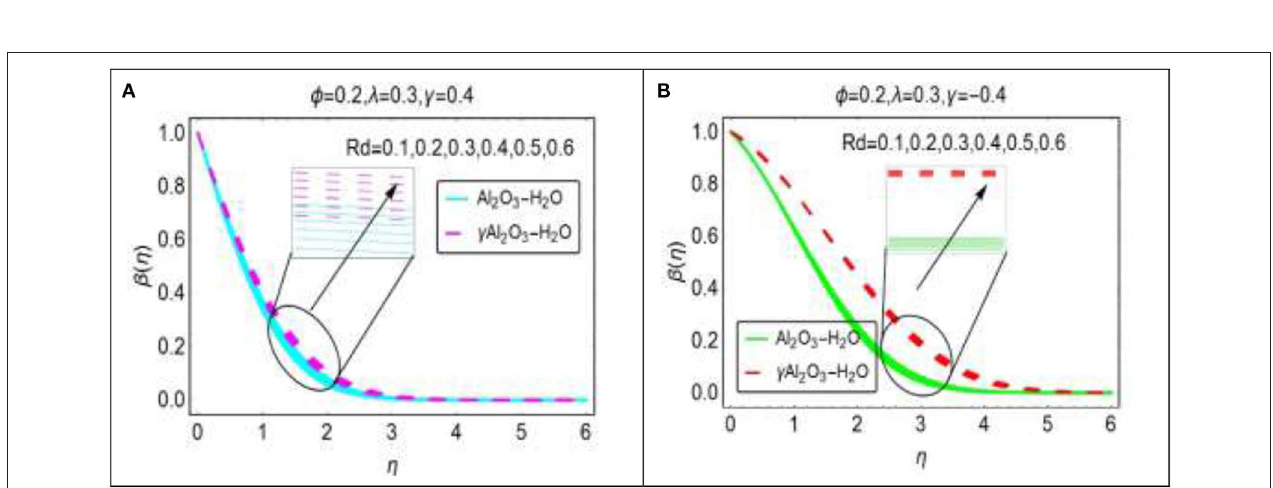
FIGURE 10 | The effects of Rd on dimensionless temperature β ( η ) for (A) γ = 0.4, (B) γ = − 0.4.